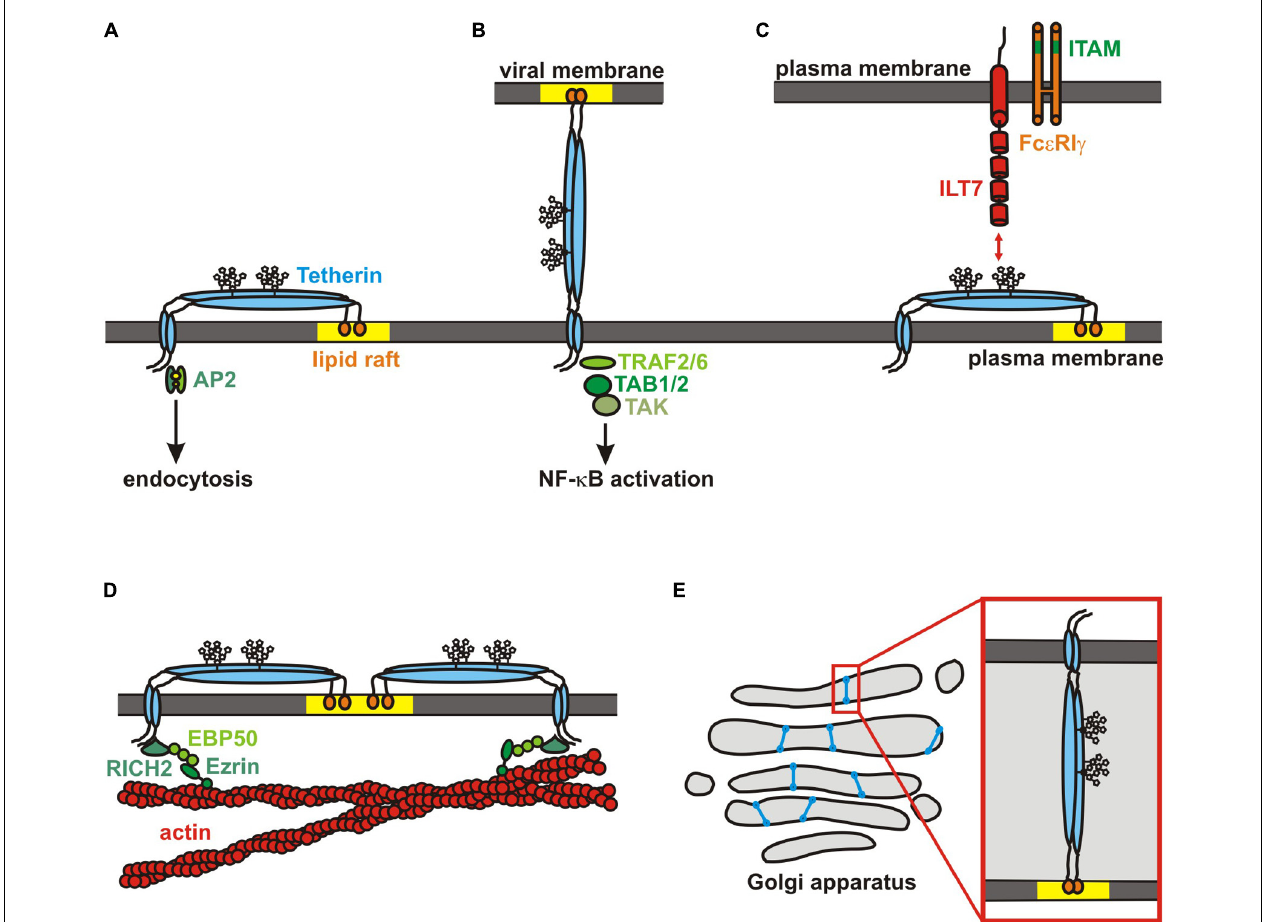
recruited to the N-terminus upon virion binding. Subsequent recruitment of TABs and activation ofTAK1 induces an NF- κ B-dependent antiviral immune response. (C) Tetherin interacts with ILT7 on pDCs. ILT7 forms a complex with Fc ε RI γ , which contains a cytoplasmic ITAM. (D) Tetherin forms a picket fence around lipid rafts and links them to the underlying actin cytoskeleton via RICH2/EBP50/Ezrin. (E) Hamster tetherin is required for maintenance of the Golgi apparatus. It may connect and stabilize opposite membranes in the Golgi cisternae or sense their curvature and